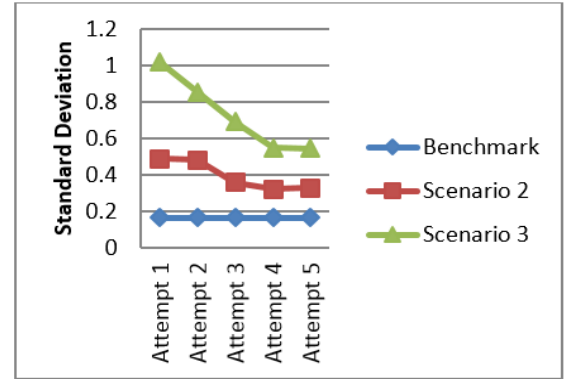
Figure 6. Standard deviation of benchmark and all scenarios